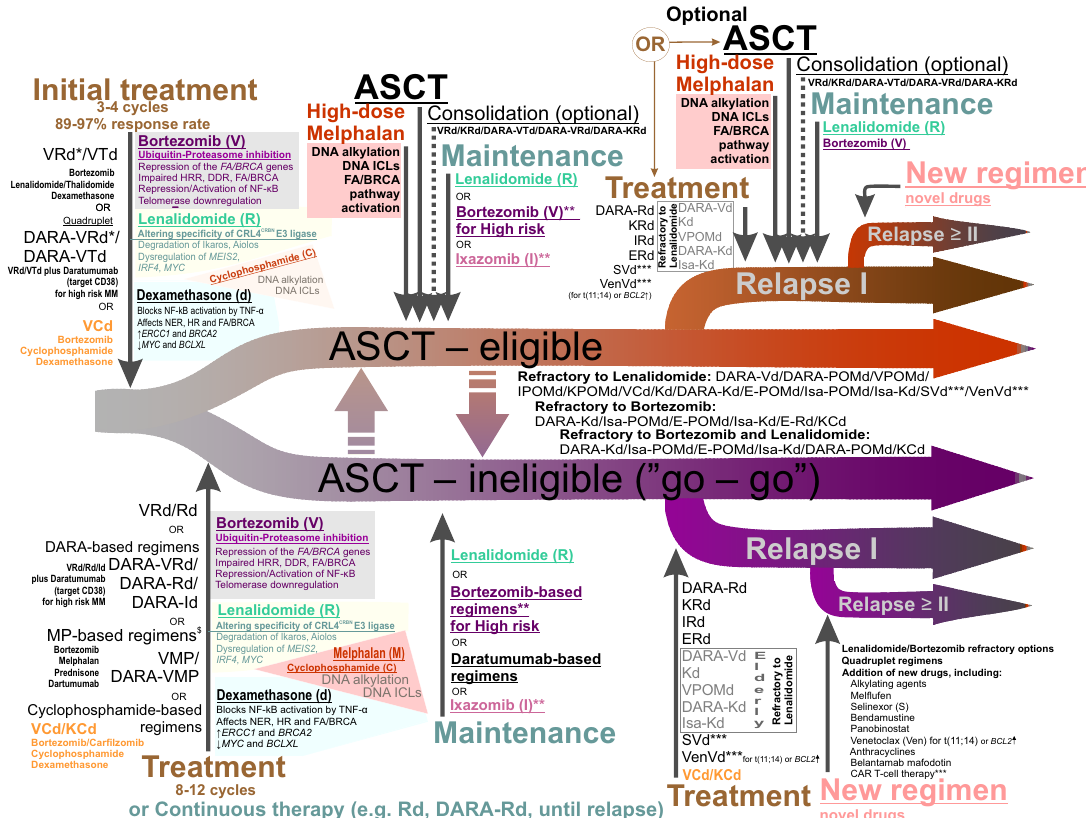
Figure 2. MM treatment outlines. The schemes align with the latest recommendations and studies and include available options for MM treatment as well as standards of care [87,88,90,91,103]. Action of some drugs on DNA integrity or pathways affecting DNA metabolism/repair is shown on the scheme. All patients can be subdivided into three categories based on frailty: “go-go”, “slow-go”, and “no-go” [111]. “Slow-go” and “no-go” categories are usually treated using the reduced intensity regimens or dose-adjusted regimens and are not shown on the scheme. Treatment for the “no-go” category excludes chemotherapeutic drugs and includes agents with low toxicity, mostly for palliative care [111]. The “go-go” category and to some extent the “slow-go” category are shown on the scheme. VRd * can be used as induction (initial) therapy for newly diagnosed and transplant-eligible patients with MM and is associated with a progression-free survival longer than 4 years and overall survival at 4 years higher than 80% [87,103]. The alternative scheme is VTd, which is slightly less efficient [103]. The addition of the monoclonal antibody daratumumab targeting CD38 to the standard VRd or VTd regimen (Quadruplet regimen, Dara-VRd *, or Dara-VTd) is recommended for high-risk patients [87]. DARA-Rd is also an important alternative to VRd in newly diagnosed MM [112]. Besides that, VCd can be used as an induction scheme [88]. High-dose melphalan and ASCT give a good response and provide the longest remission [87,102]. Single-agent lenalidomide, administered continuously until disease progression is considered the standard of care for maintenance, and bortezomib can be used for high-risk patients. In addition, ixazomib can be considered in place of bortezomib [87,103,113]. If the disease relapses, another ASCT can be tried for eligible patients [100–102,114,115]; new treatment regimens are usually considered, including quadruplet schemes and new drugs [87]. The alkylating agent cyclophosphamide can be used instead of immunomodulatory agents as treatment for refractory patients and in patients with renal dysfunction in combination with bortezomib and dexamethasone; this setting can also be used for induction therapy in ASCT-eligible patients [87,116–125]. Melphalan and prednisone-based therapy$ can be used for ASCT-ineligible patients and often is represented by VMP or DARA-VMP schemes [88]. Continuous therapy or initial therapy with maintenance can be used in a non-transplant setting [113]. A multi-regimen, including bortezomib, an immunomodulatory drug,